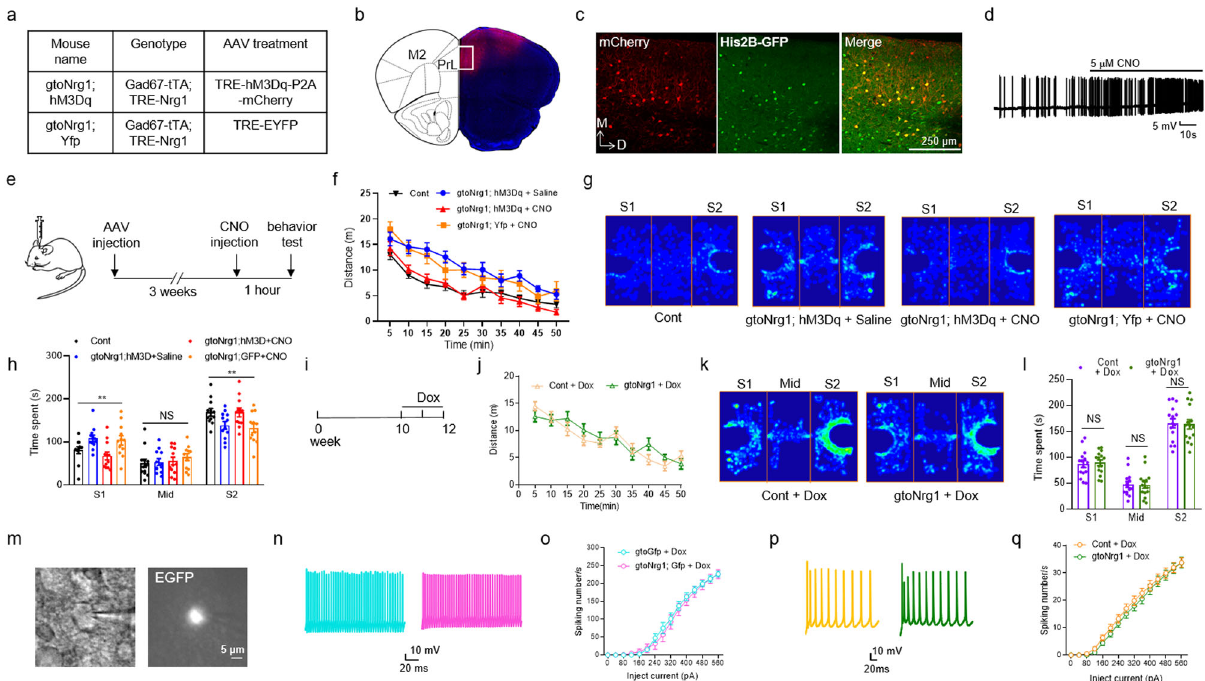
Fig. 6 Rescue of behavioral de fi cits and cortical disinhibition in gto Nrg1 mice. a The genotype and AAV treatment in different mouse lines. b Diagram to show the brain regions infected by AAV. c Expression of mCherry in GABAergic interneurons from the rectangle in panel b . AAV expressing TRE-hM3Dq- P2A-mCherry were injected into the PFC of gtoGfp mice. The resulting PFC slices were subjected to immuno fl uorescence. Three independent experiments were repeated to get similar results. Scale bar, 250 μ m. d Increased fi ring of FS-GABAergic interneurons by CNO in the PFC slices of gto Nrg1 ; Gfp mice. The AP of FS-GABAergic interneurons were recorded before and after treatment with 5 μ M CNO. e Experimental design. Three weeks after stereotaxic injection of AAV, the mice were received i.p. injection of CNO (5 mg/kg) 1 h before behavioral tests. f Rescue of hyperactivity in gto Nrg1 ; hM3Dq mice by CNO. Shown is travel distance in the fi rst 50 min during the open- fi eld test. F (3, 50) = 7.571, P = 0.0003, two-way ANOVA, n = 13 for each group.